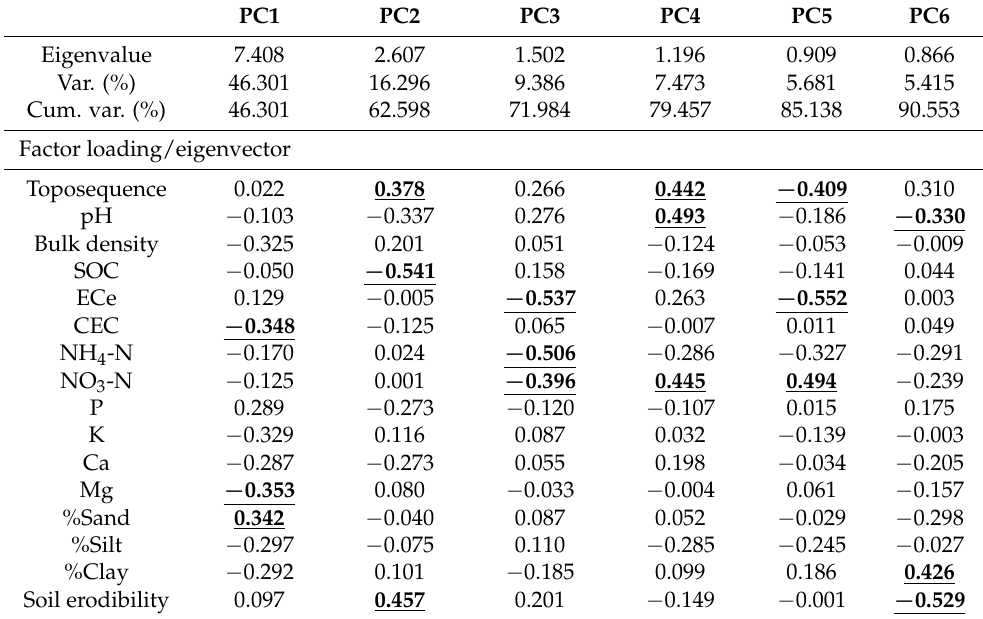
Table 3. Principal components (PCs), eigenvalues, percentage of variance explained by the PCs (% Var.) and cumulative percentage of variance explained by PCs of soil properties and toposequences for terraced paddy field and upland rice